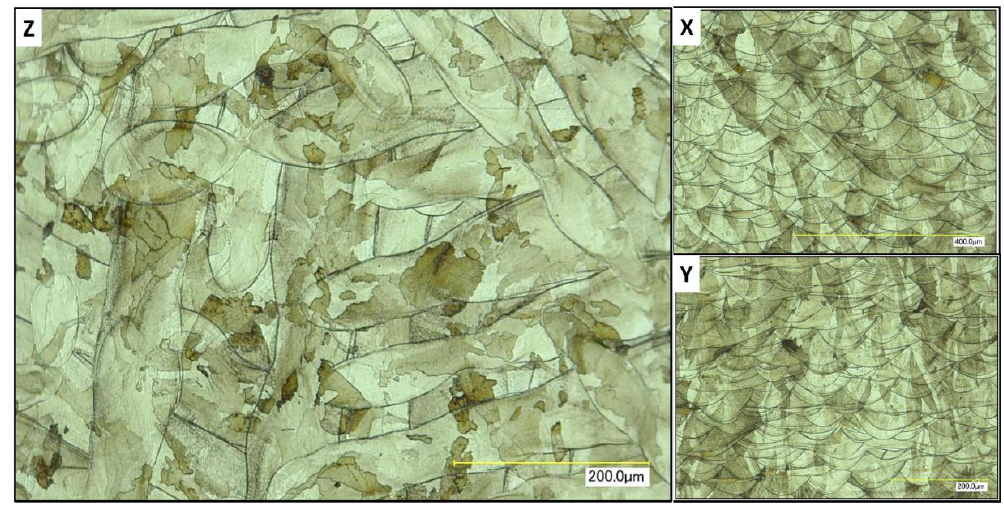
Figure 14. Illustration of micro-sections of cube printed with Powder B. Scale bars are ( X ) 400 µ m, ( Y ) and ( Z ) 200 µ m. X , Y and Z refer to the faces of the cube in relation to the melt pool ( Z